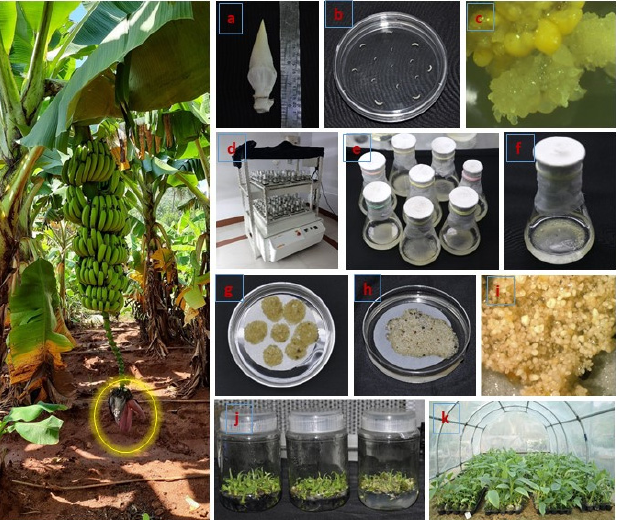
Figure 5. Development of high frequency embryogenic cell suspension cultures in banana (kindly provided by Dr M Saraswathi, NRCB, Trichy, India): ( a ) Explant; ( b ) Initiation of floral hands on callus induction medium; ( c ) Embryogenic calli (microscopic view); ( d ) ECS in orbital shaker; ( e , f ) Embryogenic cell suspension; ( g , h ) Regeneration or maturation; ( i ) Microscopic view of matured somatic embryos ( j ) Embryo germination; ( k ) Primary hardening.